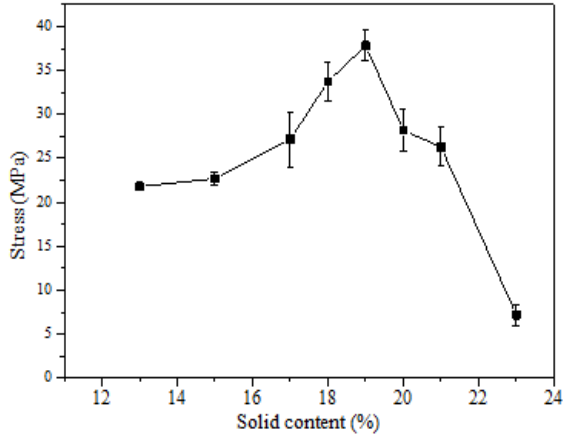
Figure 5. Effect of solid content on compression properties of p–DN hydrogel.